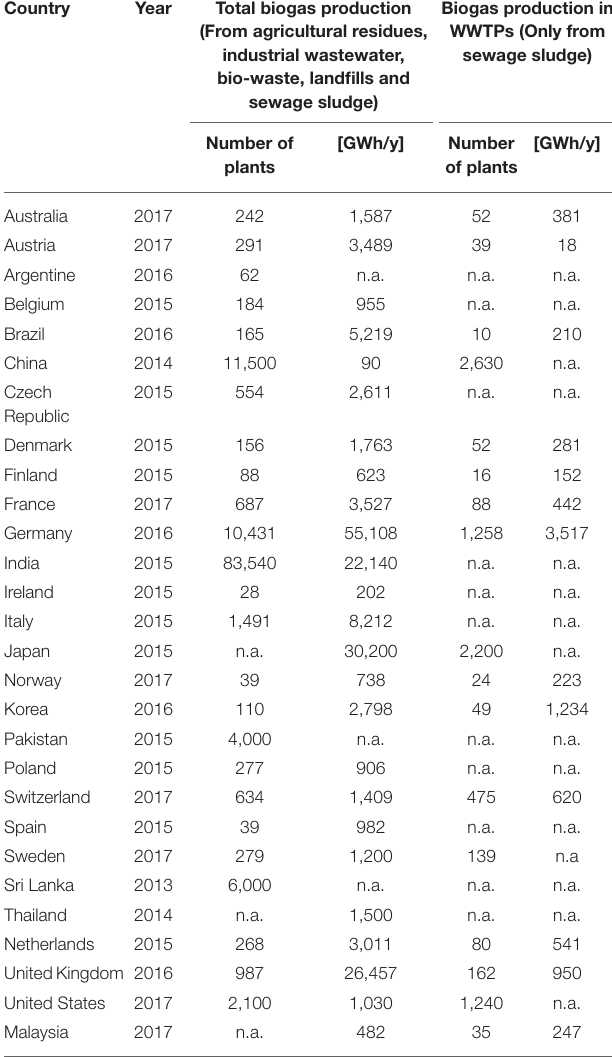
into CH 4 and CO 2 . In term of the technical aspect, improper TABLE 2 | Biogas production in several countries. operation of the anaerobic digestion will lead to low biogas yield. Biogas production in Country Year Total biogas production Sun et al. (2014) showed that increasing fat content in municipal WWTPs (Only from (From agricultural residues, solid waste ( < 60%) could increase CH 4 yield significantly. The sewage sludge) industrial wastewater, study also observed a decrease in CH 4 yield when the fat bio-waste, landfills and sewage sludge) Number of [GWh/y] Number [GWh/y] plants of plants